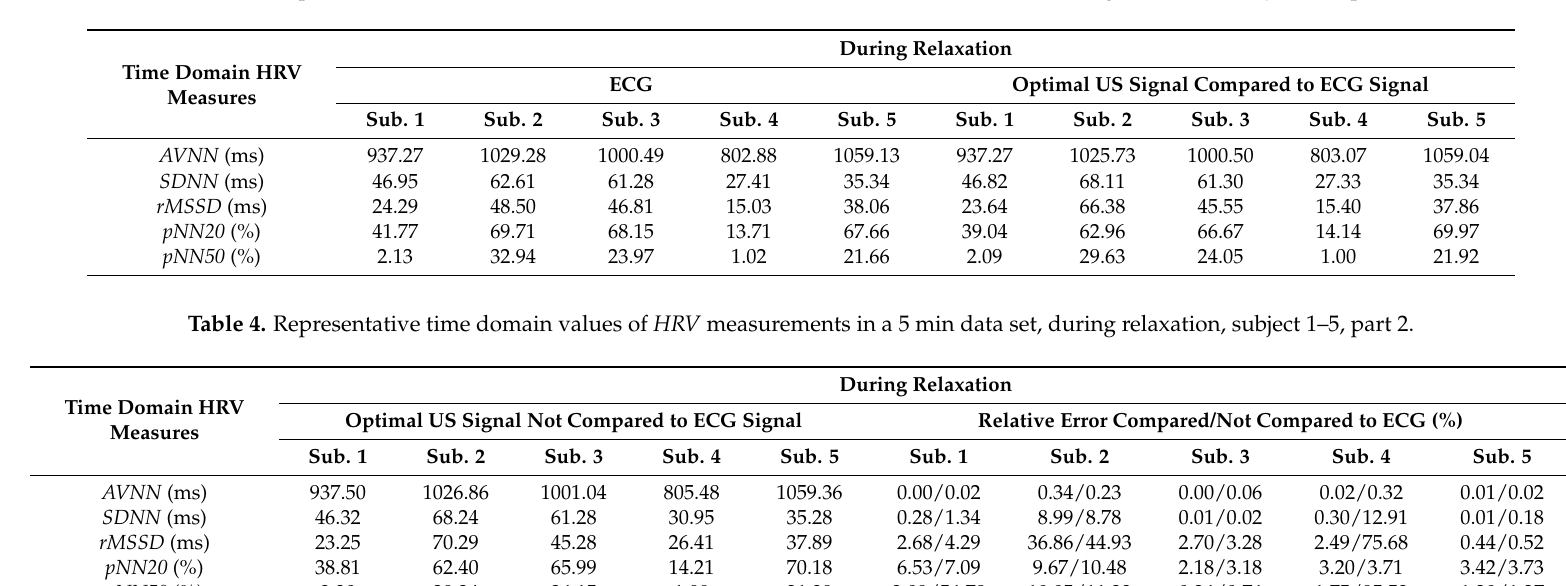
Table 3. Representative time domain values of HRV measurements in a 5 min data set, during relaxation, subject 1–5, part 1.